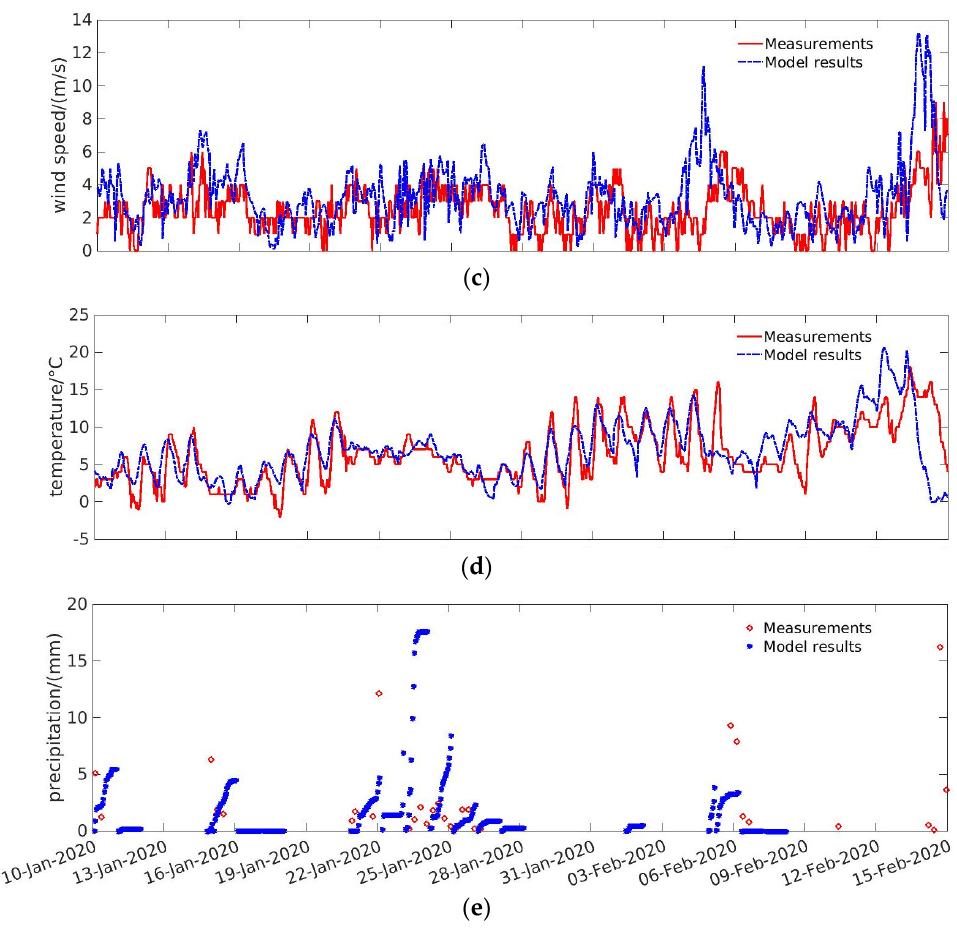
Figure 2. Meteorological parameters. The four figures show comparisons of measured and modelled ( a,b ) wind direction, ( c ) wind speed, ( d ) air temperature, and ( e ) precipitation at Tianhe Station between 10 January and 15 February 15 .